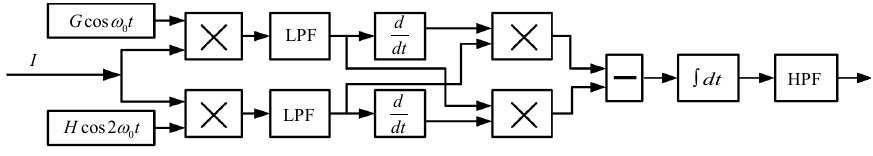
Fig. 2 PGC demodulation scheme.